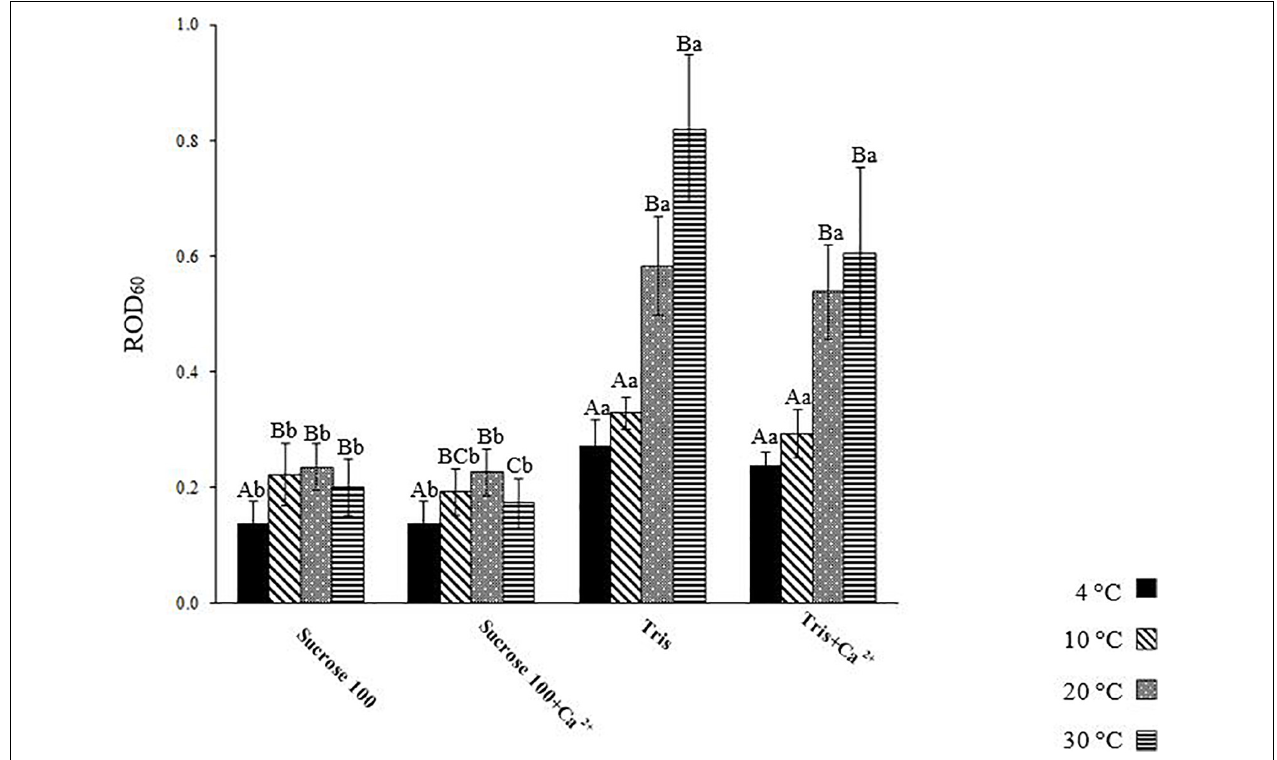
FIGURE 5 | Relative optical density of L. lota spermatozoa at 60 s post-activation (ROD 60 ) at 4, 10, 20, and 30 ◦ C in Tris, Tris + Ca 2 + , Suc 100, and Suc 100 + Ca 2 + . Different uppercase letters indicate significant difference ( P < 0.05) among studied temperatures in each solution. Different lowercase letters indicate significant difference ( P < 0.05) among studied solutions at each temperature. Data are expressed as mean ± SD. Values with the same superscript do not differ significantly ( P >